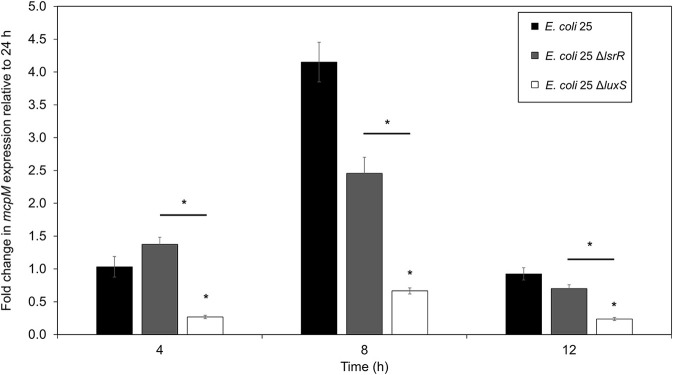
Transcription of mcpM is significantly down regulated in AI-2 QS deficient E. coli 25 strains. Transcriptional analysis of the mccPDI effector mcpM for E. coli 25 ΔluxS, E. coli 25 ΔlsrR mutant and isogenic wild-type strain in M9 media over time by qPCR. Fold change is expressed relative to mcpM expression in M9 at 24 h (error bars = SEM; three independent replicates). *P < 0.05 based on two-way ANOVA.